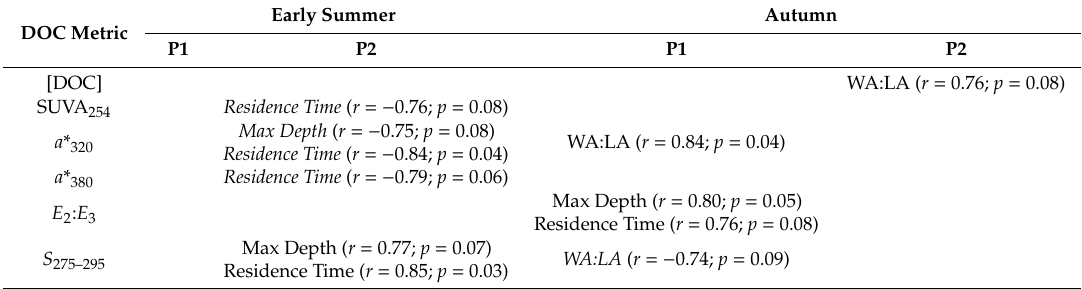
Table 4. Correlation (r) and p values for significant correlations between [DOC], SUVA 254 , a * 320 , a * 380 , E 2 : E 3 , and S 275–295 and select lake characteristics ( p < 0.10) at P1 and P2 storm samplings for Early Summer and Autumn storms. Italics indicate a negative